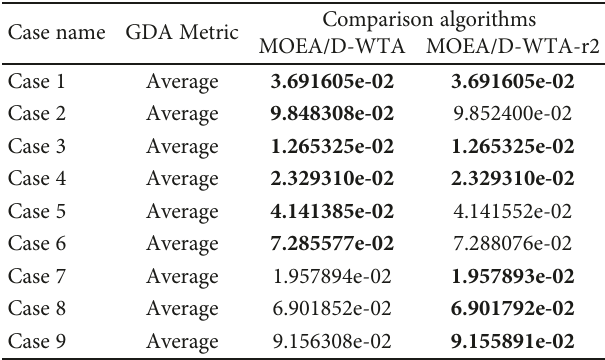
Table 5: Results of the GDA metric for MOEA/D-WTA and